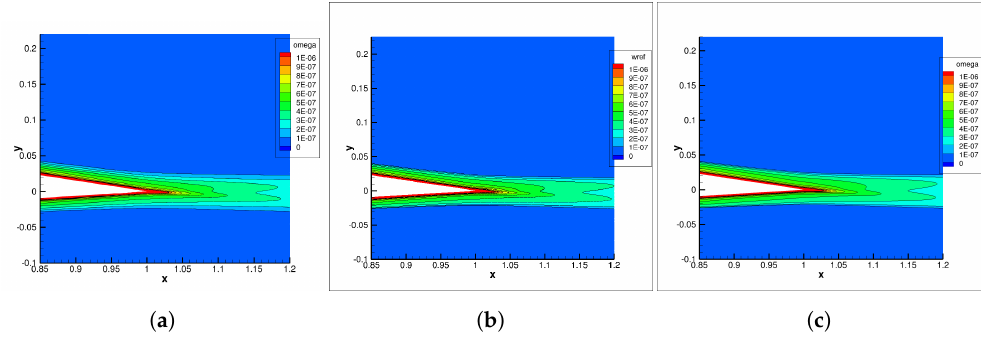
Figure 14. ω contours on Nakayama’s airfoil predicted with Shear Stress Transport model: ( a ) UNS3D-SEQ, ( b ) UNS3D-PAR, and ( c ) FUN3D. Figure 15 compares the measured velocity profiles against the predicted ones at seven locations in the airfoil’s wake. These locations, measured from the airfoil leading edge, are: 1.01, 1.05, 1.20, 1.40, 1.80, 2.19, and 3.0 x /chord. The numerical predictions were done using the UNS3D-PAR code with the Spalart–Allmaras and the Shear Stress Transport models. The velocity profiles predicted using the Shear Stress Transport model matched the experimental data better than the Spalart–Allmaras model, although the Spalart–Allmaras model predicted the velocity profiles quite well.